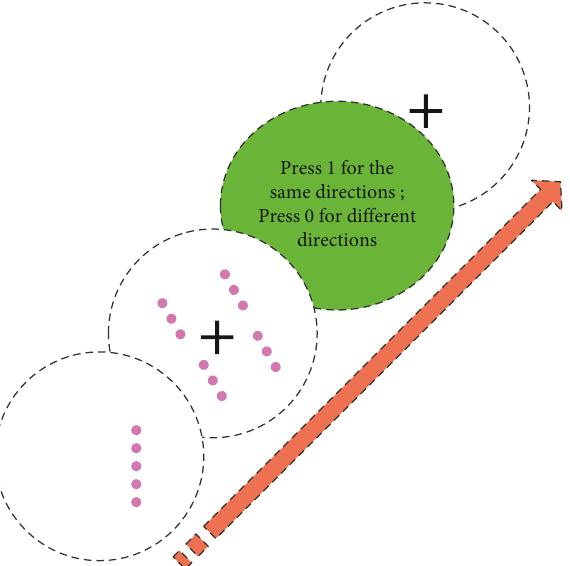
Figure 1: Schematic diagram of the language judgment